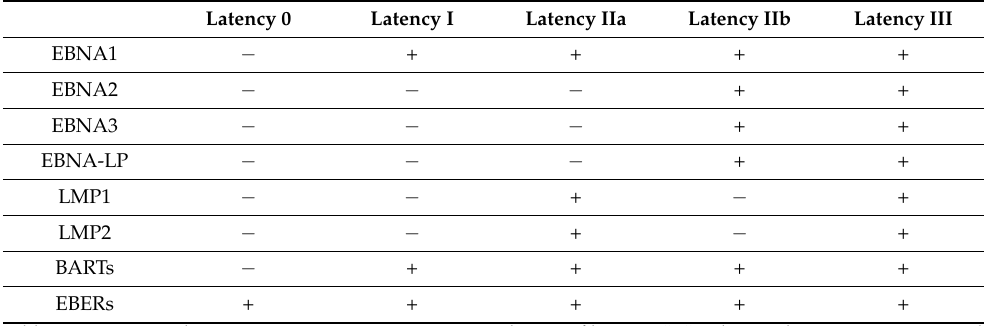
Table 1. Patterns of EBV protein expression during latency.